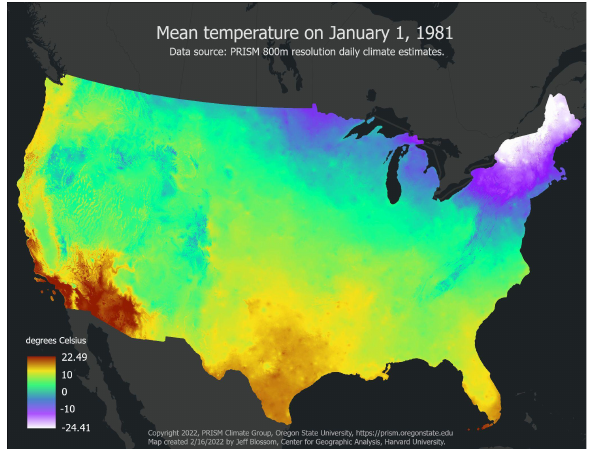
Figure 2 . Mean temperature map for January 1, 1981 using 800m PRISM climate